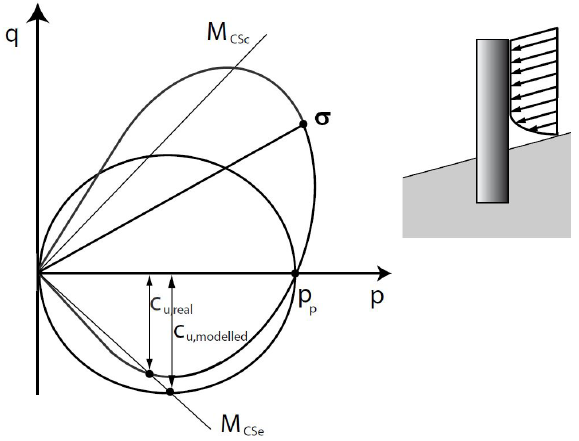
Figure 2: Undrained shear strength in triaxial extension resulting from the application of isotropic model and the real shear strength.